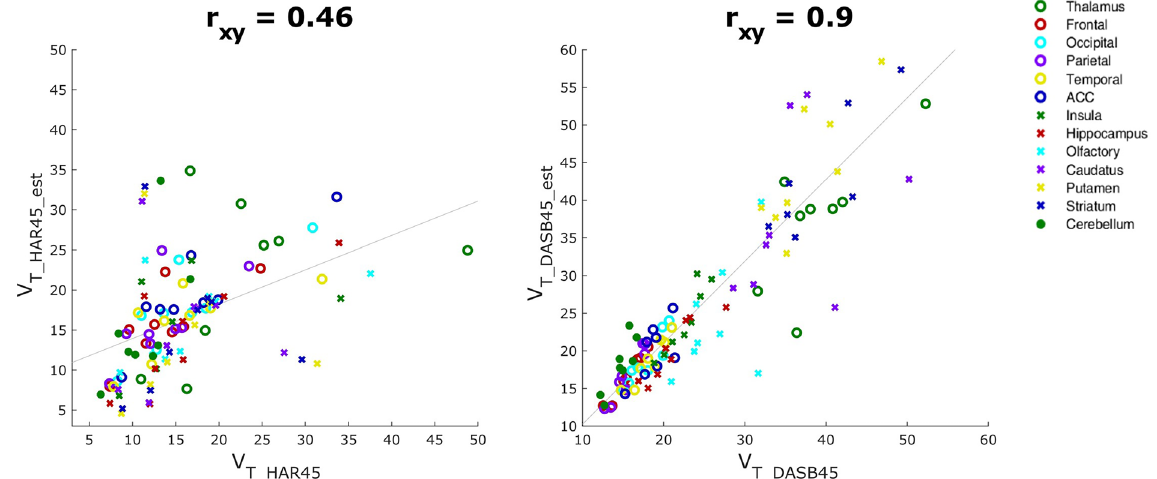
Figure 5. Scatter plots showing the correlation between real and estimated V T of the second tracer V T , when [ 11 C]DASB is applied first (left) and when [ 11 C]harmine is applied first (right). All 13 ROIs considered for the analysis are shown in the figure label with different makes in different